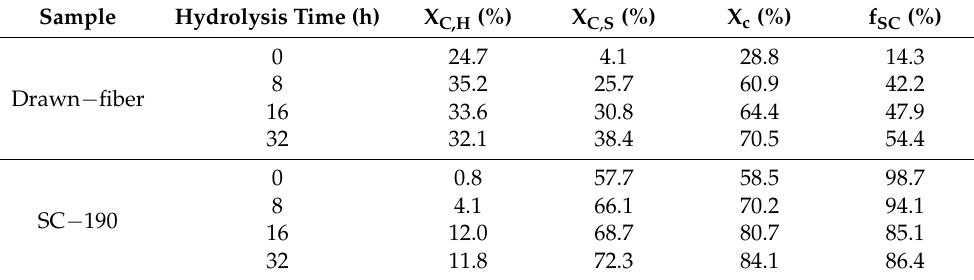
Figure 6. WAXD patterns of PLLA/PDLA fiber hydrolyzed for different times, ( a ) drawn − fiber, ( b ) SC − 190. Table 5. Crystallization parameters of PLLA/PDLA fiber hydrolyzed for different times.